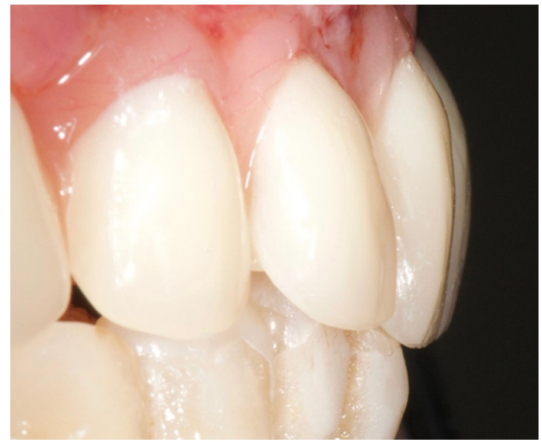
Figure 7. Provisional prosthesis was screwed, and the occlusal check was